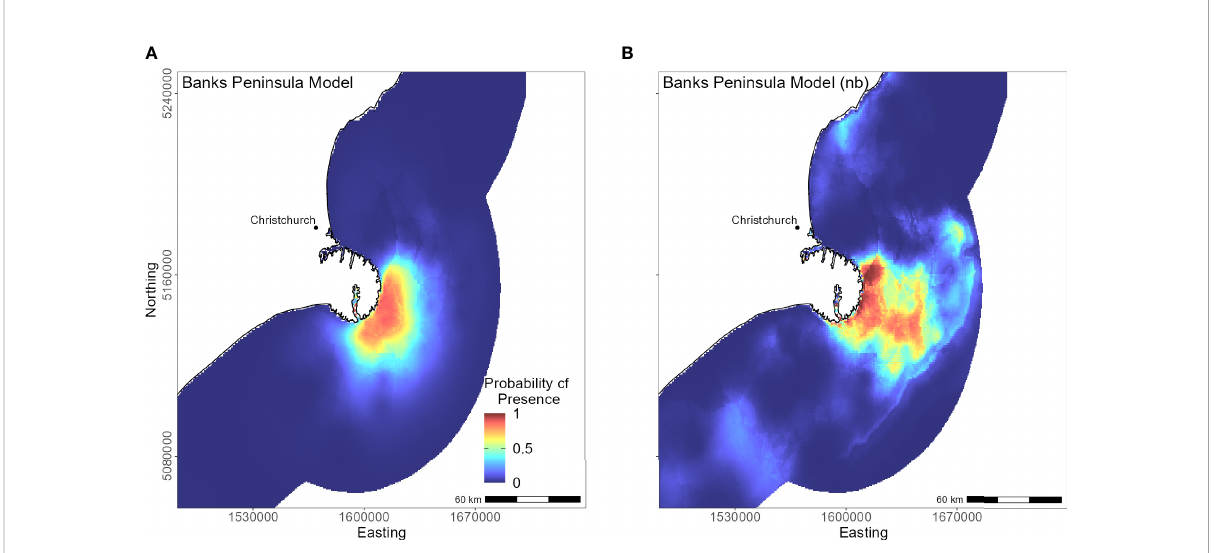
FIGURE 6 Distribution of suitable foraging habitat for yellow-eyed penguins breeding on Banks Peninsula. The left map (A) depicts the predicted probability of presence (cloglog) with distance to nearest colony included a predictor variable, while the right map (B) does not include distance to colony as a predictor (nb